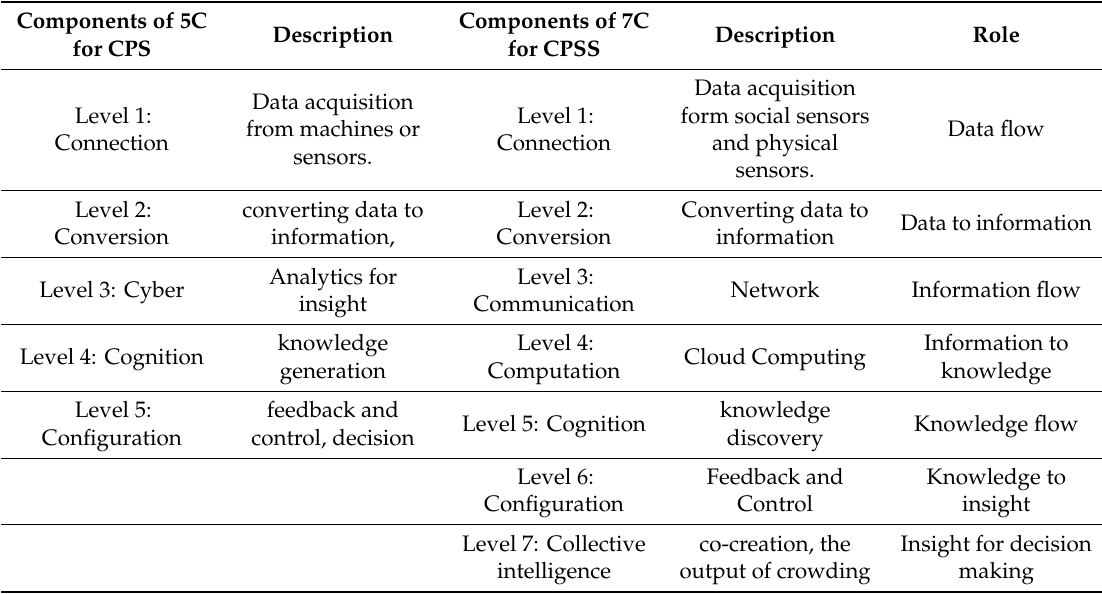
Table 3. Comparison of components between the proposed 7C for CPSS and the existing 5C for CPS. Components of